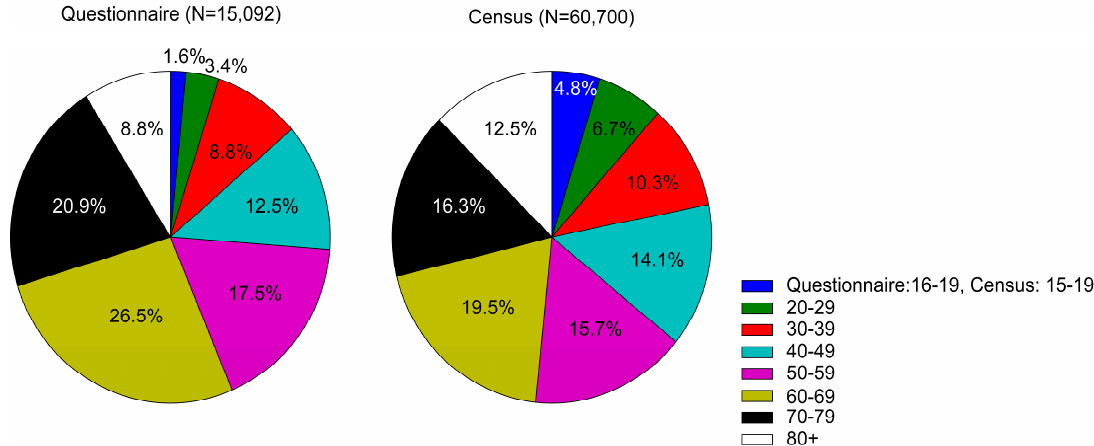
Figure 3. Age composition ratio comparison between the survey and the